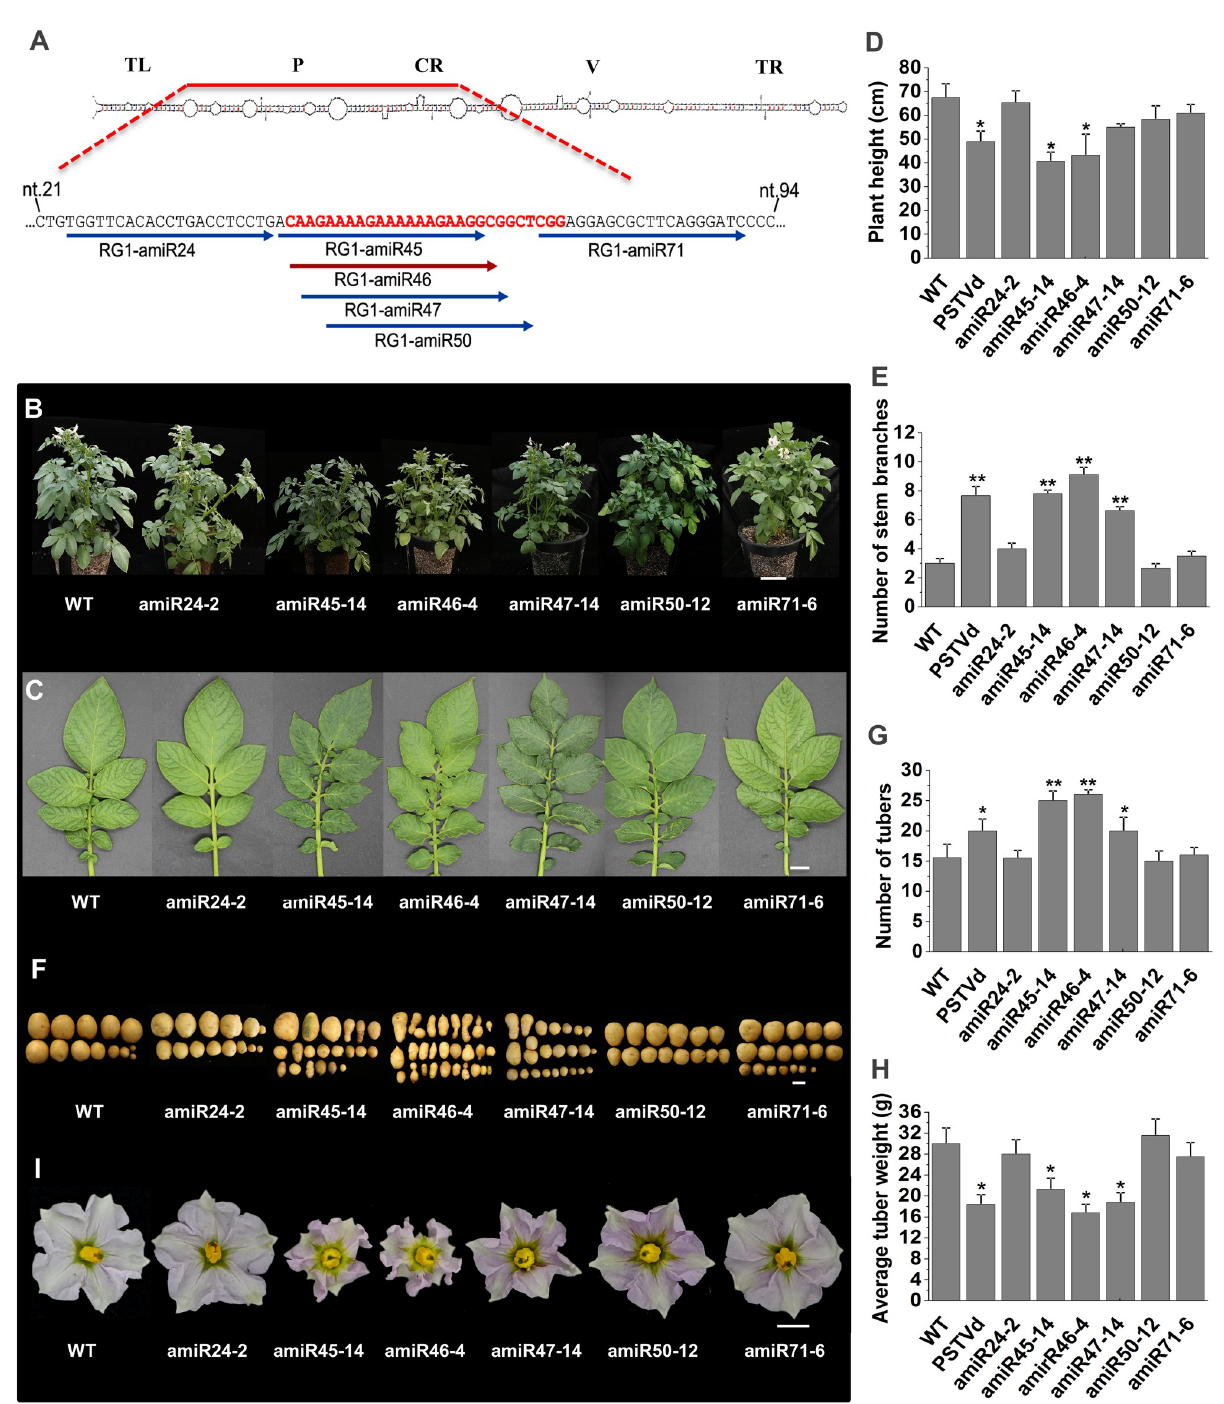
Fig 5. Evaluation of transgenic lines expressing six PSTVd amiRNA vectors. (A) Rod-like native structure of PSTVd-RG1. The sequence of the upper portion of the V(irulence) M(odulating) region within the Pathogenicity domain [P] is highlighted in red, and sequences of four amiRNAs derived from the upper portion of the VM region as well as two other amiRNAs derived from flanking sequences are shown below. (B) Whole plant phenotypes. Scale bars = 10 cm. (C) Leaf phenotypes. Scale bars = 1 cm. (D) Comparison of average plant height and (E) number of stem branches for amiRNA- expressing and control plants. (F) Tuber phenotypes. Scale bars = 3 cm. (G) Comparison of tuber numbers and (H) average tuber weights for amiRNA- expressing and control plants. (I) Flower phenotypes for amiRNA-expressing and control plants.